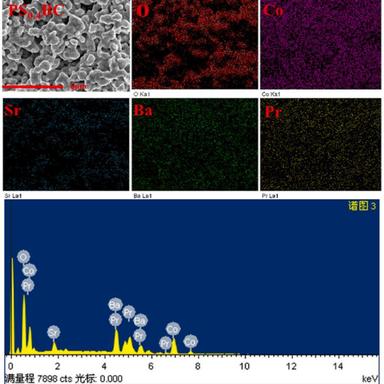
Distribution map of Pr0.6Sr0.4BaCo2O5+δ component elements at 5000x